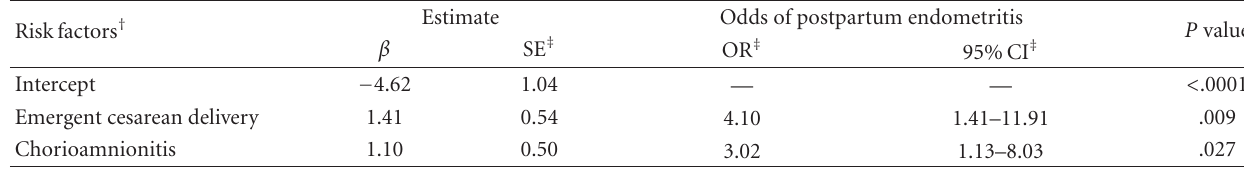
Table 5: Risk factors variables influencing postpartum endometritis in a stepwise odds model .